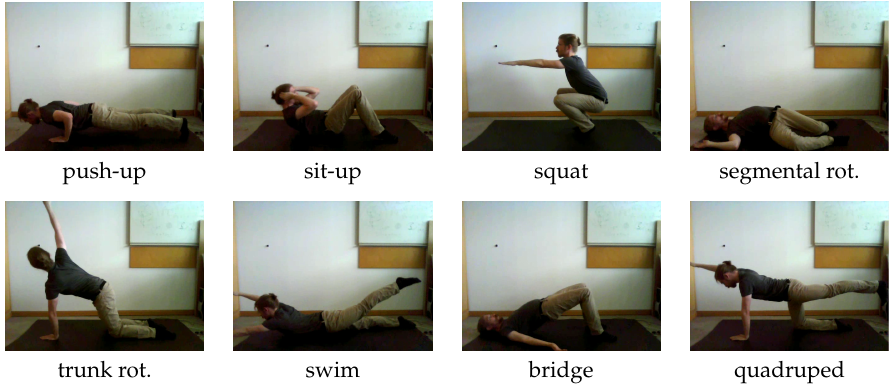
Figure 1. Eight exercises we recorded on our proposed sensing